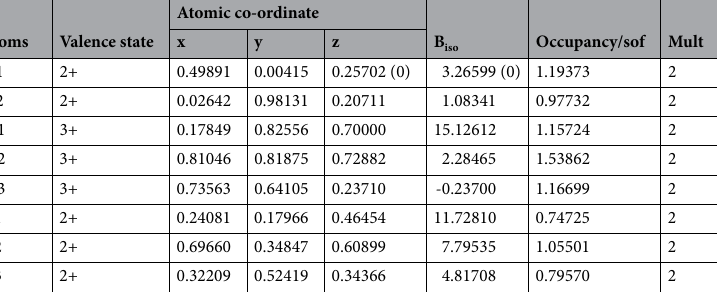
Table 2. Comparison of refinement crystallographic data for atom parameters of SrAl 2 O 4